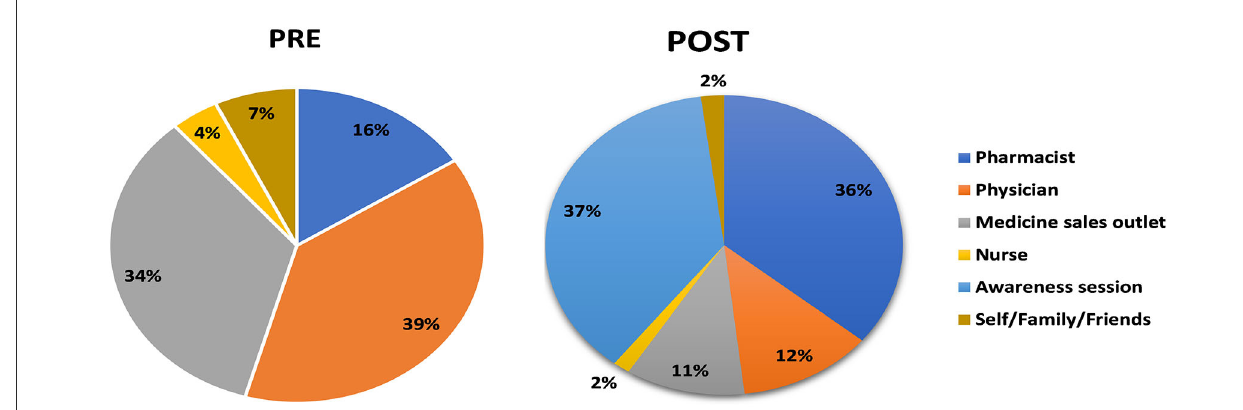
FIGURE10 Pre- and post-intervention understanding of the consequence of the use of a household spoon.